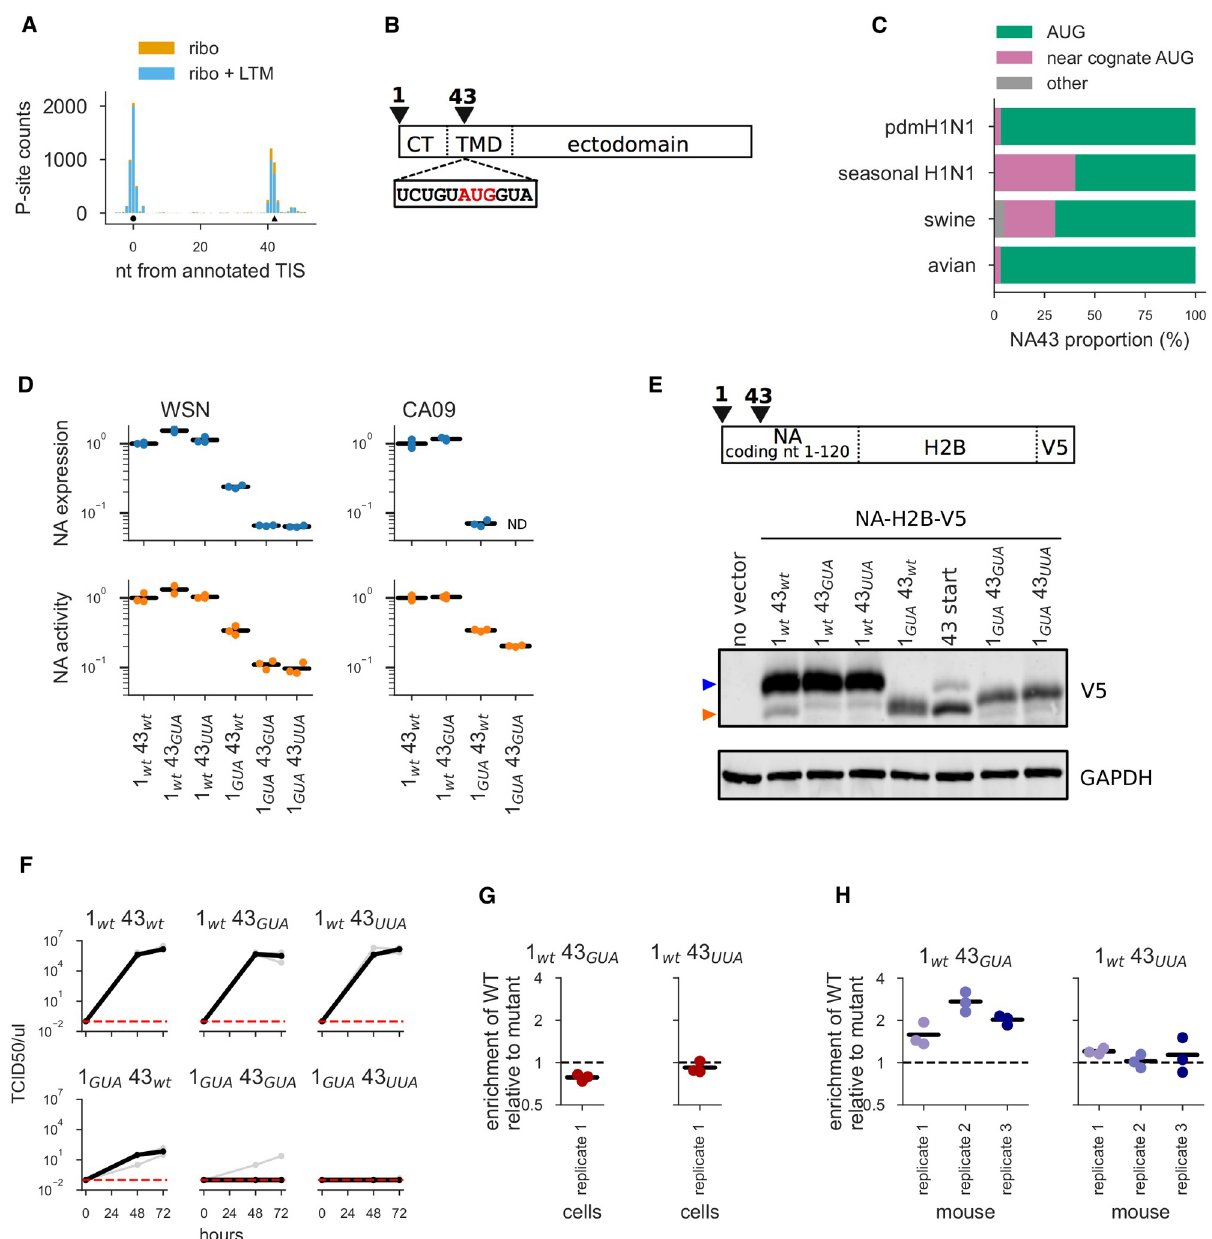
Fig 5. Characterization of the NA43 protein generated by alternate translation initiation in the NA gene. (A) P-site counts from Ribo-seq and Ribo-seq + LTM assays are shown as stacked bar graphs for the 5 0 end of the mRNA for our +vir sample. The candidate annotated TIS (circle) at coding nucleotide position 1 and the downstream TIS (triangle) at coding nucleotide position 43 are indicated below the coverage plots. (B) Schematic of NA’s primary sequence. NA’s cytoplasmic tail (CT) spans amino acids 1-6, the transmembrane domain (TMD) spans amino acids 7-35, and the ectodomain spans amino acids 36 to 453. The inset shows the AUG43 codon (in red) and surrounding sequence. (C) Most NAs in major lineages of N1 influenza have either an AUG or a near-cognate start codon at nucleotide 43. (D) Quantification of NA cell-surface protein levels and enzymatic activity in 293T cells transfected with plasmids encoding NA variants with mutations at the canonical or downstream start site. Results are shown for NA from the WSN and CA09 viral strains. Measurements are normalized relative to the mean for wildtype, and black lines indicate the mean of three measurements for all variants except for WSN 1 , which only had two measurements. ND indicates that the value was below the limit of detection. (E) Schematic of wt 43 GUA coding region of NA-H2B-V5 constructs used for Western blots. Blot of 293T cells transfected with NA-H2B-V5 constructs with mutations at the canonical or downstream start site. “43 start” is a size control construct that begins at site 43 of NA. Top panel: anti-V5 (blue arrow corresponds to full length NA and orange arrow corresponds to NA43); bottom panel: anti-GAPDH. (F) Viral titers in the supernatant at 48 and 72 hours post-transfection during reverse-genetics generation of WSN viruses carrying NA with the indicated mutations. Three independent replicates for each mutant are shown in gray, and the median is shown in black. Undetectable titers are plotted at the assay’s limit of detection of 0.1 TCID50 / μ l. (G) In vitro competition of